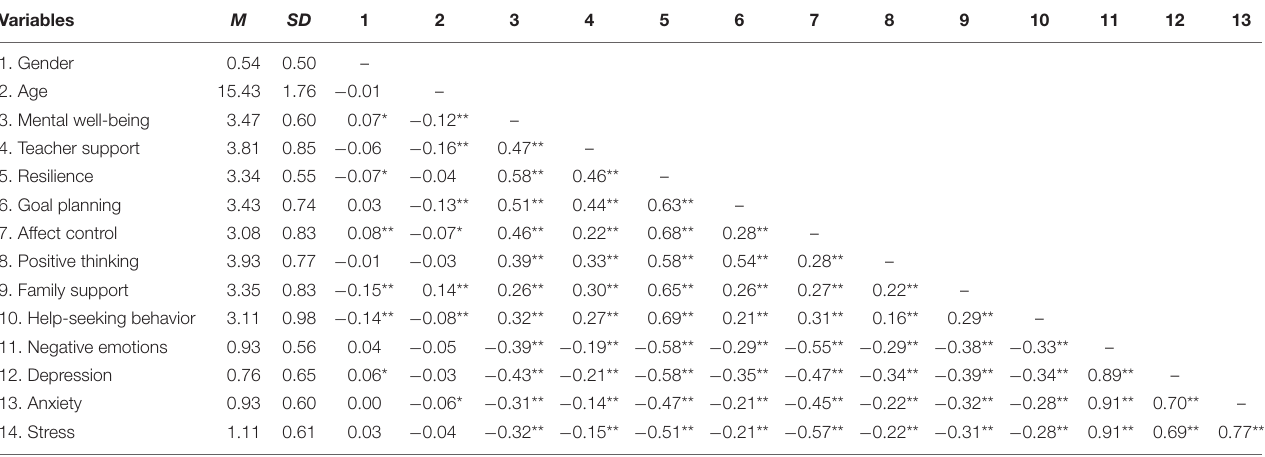
TABLE 1 | Descriptive statistics and Pearson’s correlations between the study variables. Variables